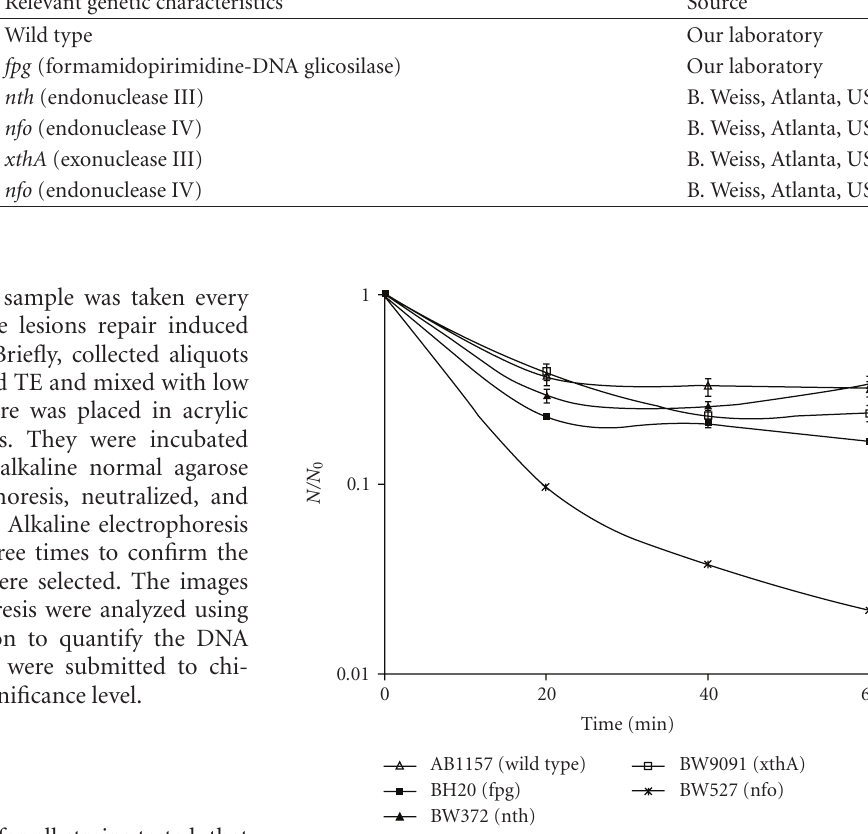
Table 1: Escherichia coli strains and plasmid with their relevant genetic characteristics for this study. Strains Relevant genetic characteristics